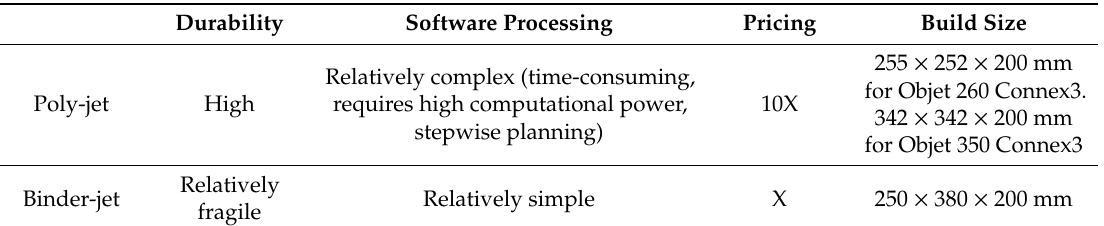
Table 1. Durability, software processing, pricing, and build size comparisons between poly-jet and binder-jet